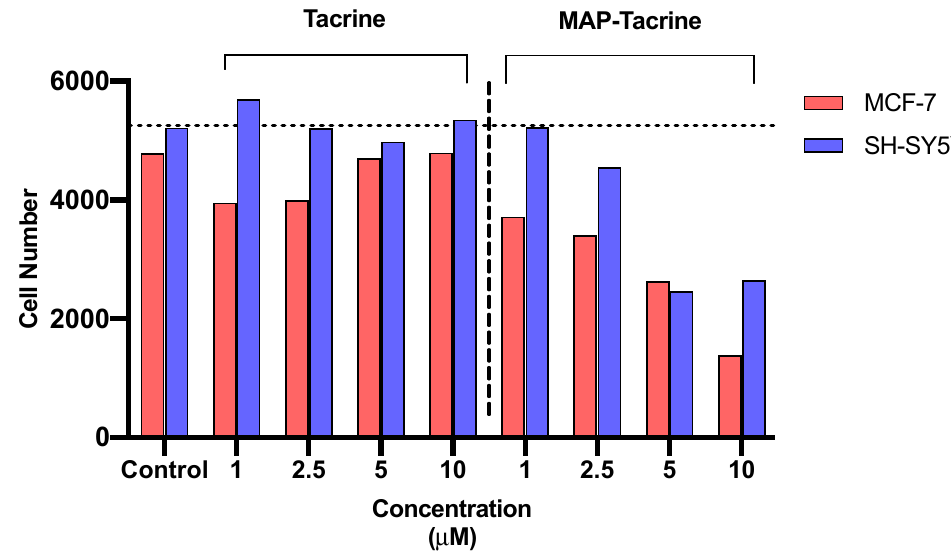
Figure 5. Cell count through Lionheart FX treatment of MCF-7 and SH-SY5Y cell lines with Tacrine and Tacrine-MAP (1, 2.5, 5, and 10 µM) after 24h incubation ( n = 1).